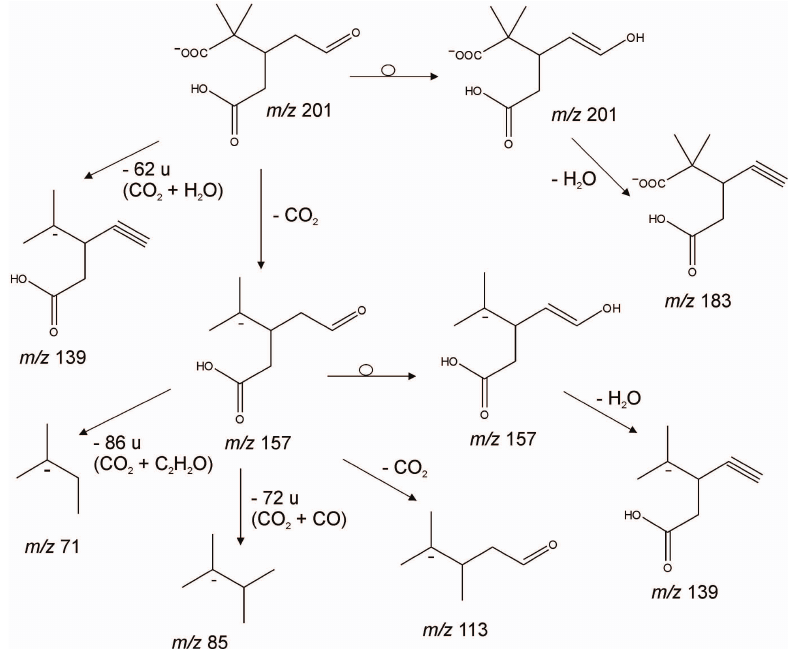
Fig. 9. Proposed structure of the m / z 201 compound and its fragmentation mechanism.